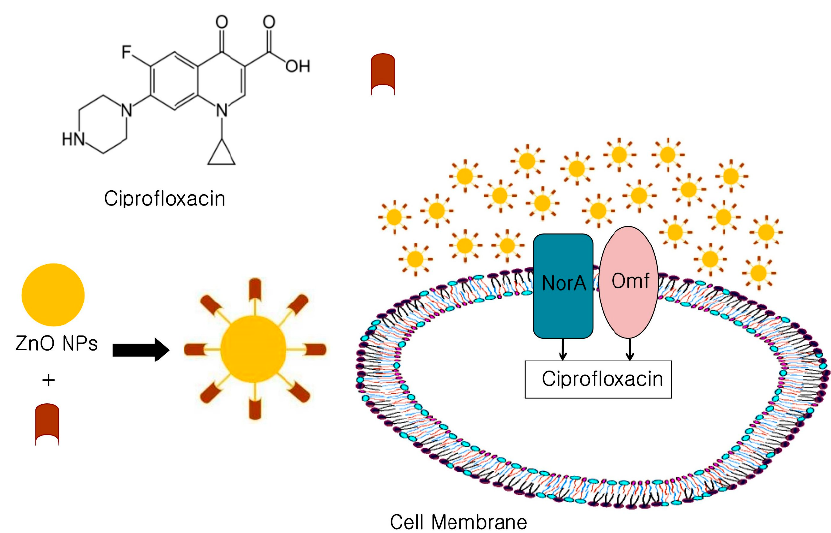
Figure 4. Schematic representation of the antibacterial mechanism of ciprofloxacin conjugated ZnO-NPs. ZnO-NP-Ciprofloxacin complex interferes with NorA (endogenous efflux transporter) and membrane Omf proteins, and thus enhances ciprofloxacin entry.